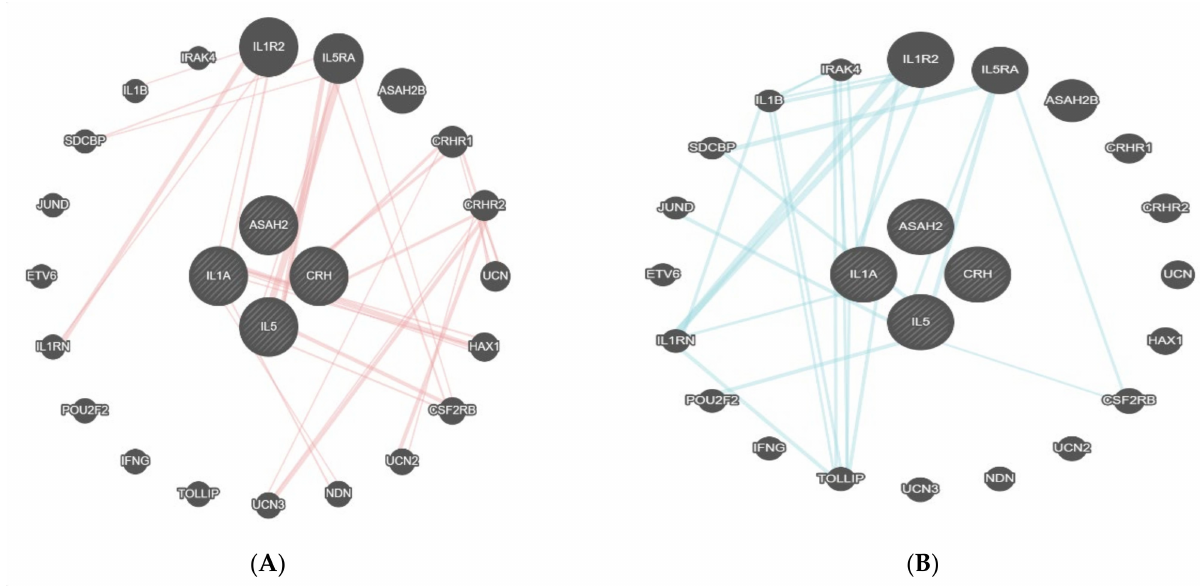
Figure 4. ( A , B ) Physical interaction table of IL1A, ASAH2, IL5, and CRH proteins. This figure shows the connection between the proteins found in the present analysis (within the circle) and the linked proteins as identified by GeneMania. The four proteins in the centre were found in the present study. All of the other encircled proteins in the periphery linked with red lines to the central proteins are the ones with a relevant physical interaction with the